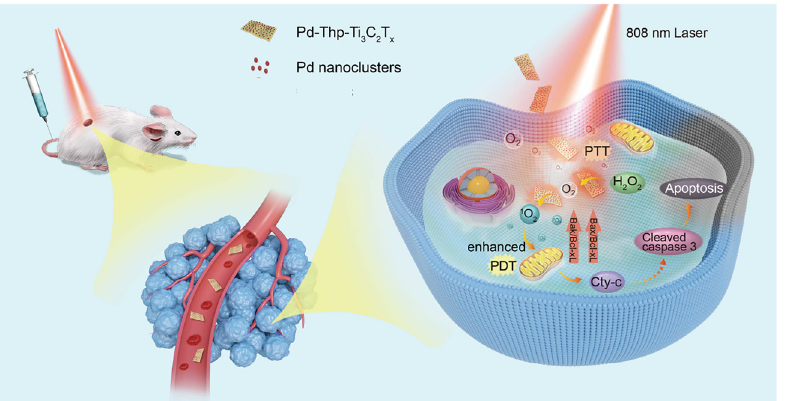
C T with enhanced nanocatalytic 3 2 x